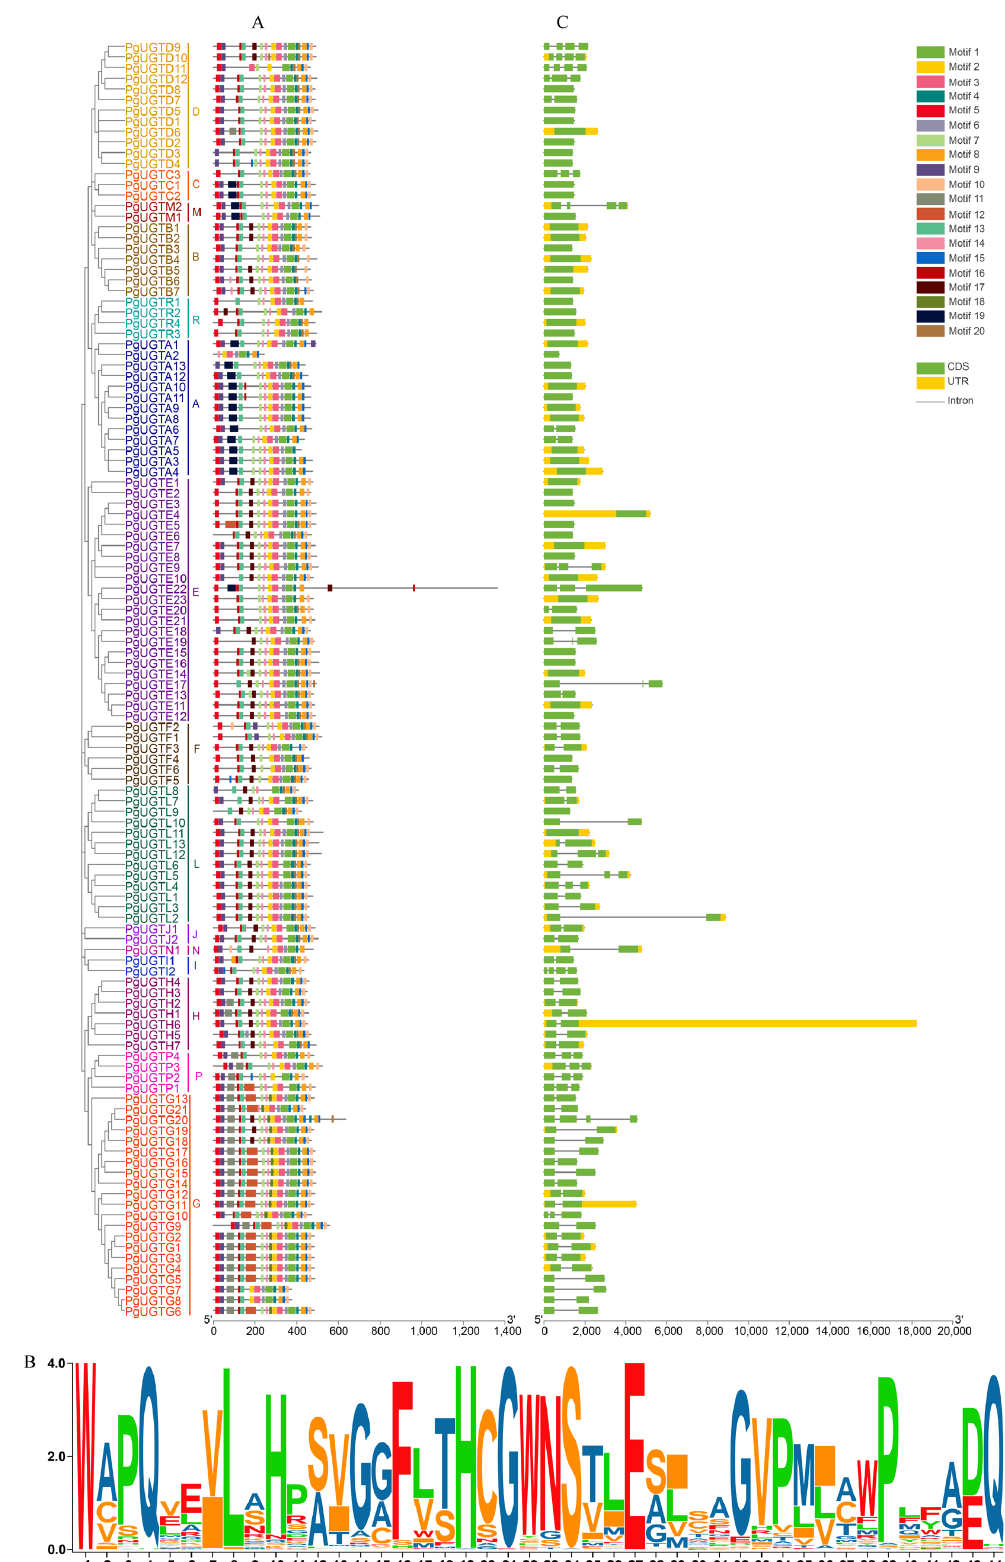
Figure 2. Conserved motifs and gene structure analysis of PgUGT s. ( A ) Distribution of the con- served motif for PgUGT proteins. The capital letters(A–J, L–N, P, and R) represent different groups. ( B ) Amino acid composition analysis of motif 1 (PSPG-box). ( C ) Gene structure of PgUGT